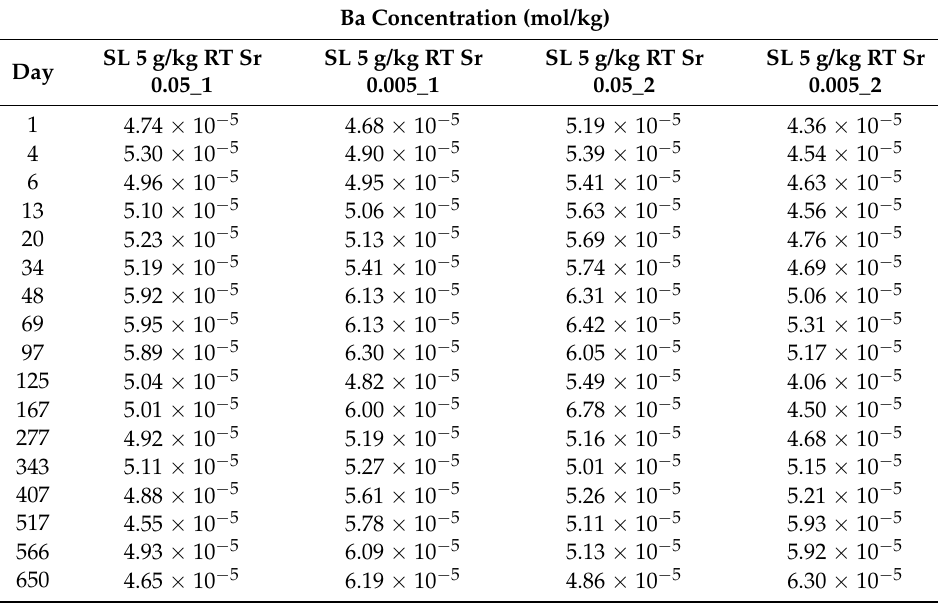
Table A13. Ba concentration of experiments with Sr in the aqueous solution at 23 ◦